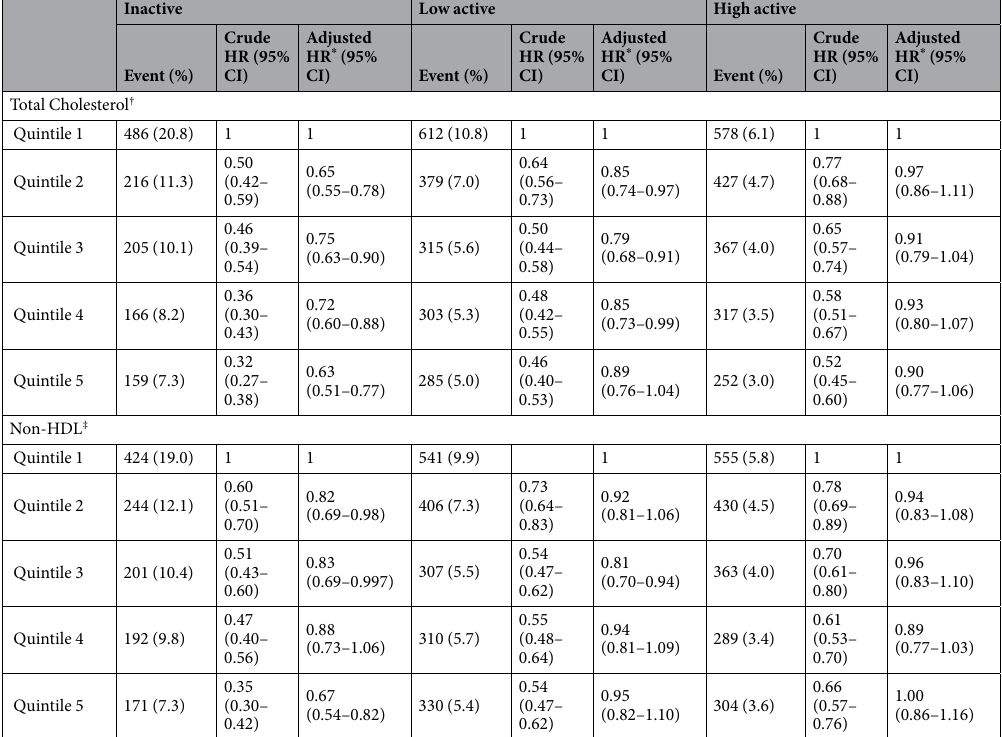
conditions. In the present study, we found that physical activity may confound the association between low TC/ non-HDL and mortality. The risk of mortality was not increased in older individuals with regular physical activ- ity, whereas in those without physical activity, the risk of mortality increased in low TC/non-HDL groups. As people get older, low cholesterol levels may not only reflect nutritional intake but also seems to be a sur- rogate for frailty and disability resulted from chronic illness and inflammatory status 11, 25–27 . Older individuals are most likely to be inactive because of comorbidities, loss of balance and diminished functional capacity 28–30 . In contrast, physical activity has favorable effects in lowering lipids and lipoproteins levels 31, 32 . Previous studies